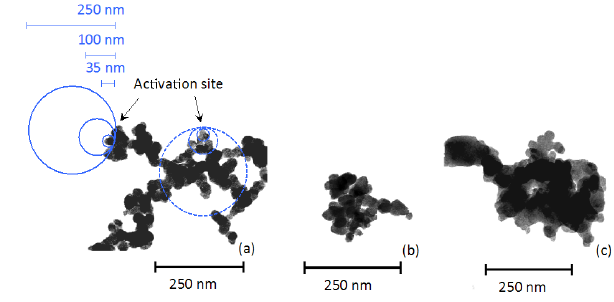
Figure 9. TEM pictures of diesel exhaust particles (DEP1): a fresh diesel exhaust particle (a) , after 1h (b) and 4h of ageing in the chamber (c) . In (a) an activation site excluding most of the particles’ soluble material in the droplet at activation is illustrated (solid, blue circles), as well as a site with more material included (dashed, blue circles), for the diameters 35, 100, and